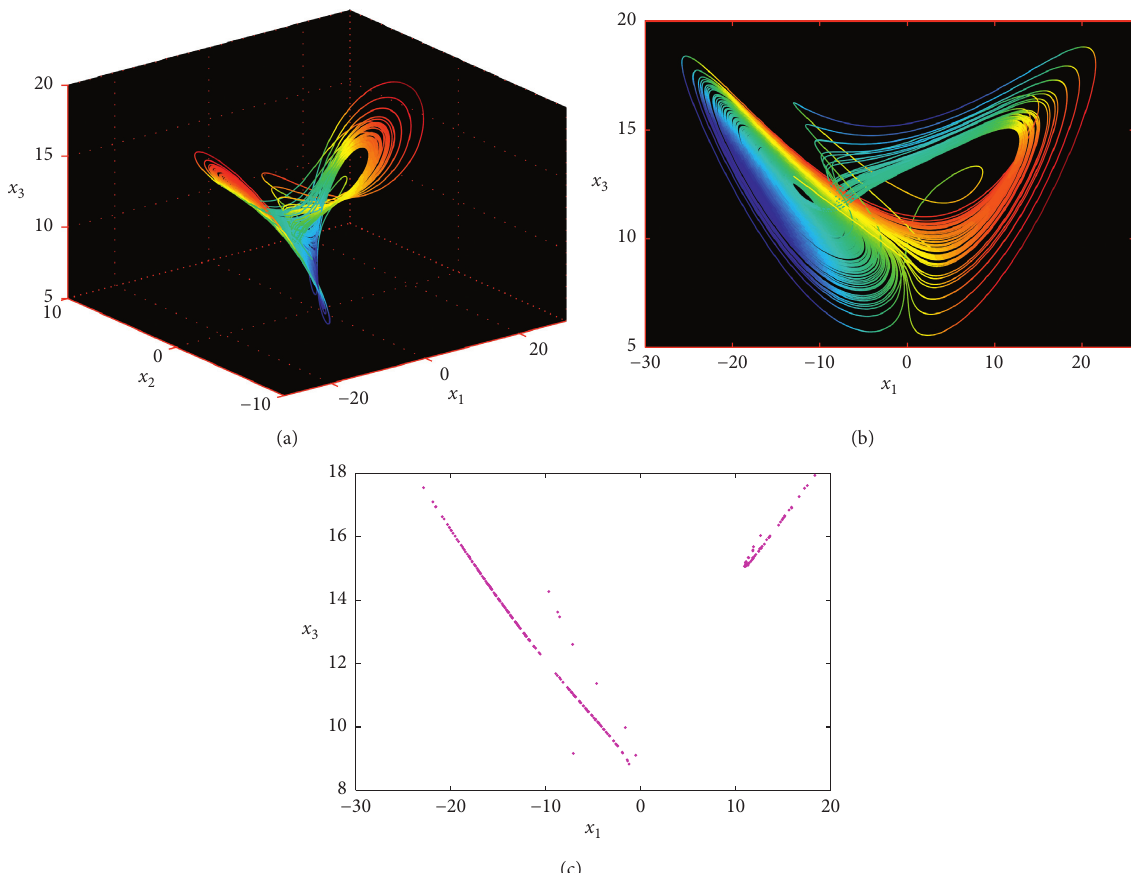
Figure 5: (a) x 1 - x 2 - x 3 phase portrait; (b) x 1 - x 3 phase portrait; (c) Poincare